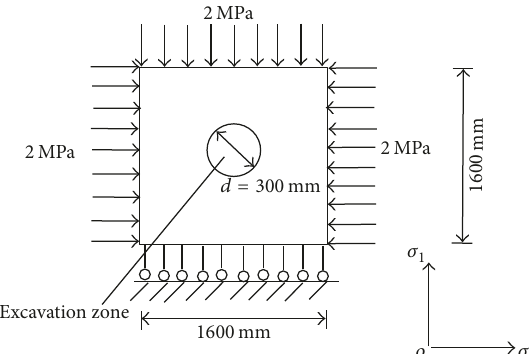
Figure 2: Simulated boundary stress conditions during the roadway